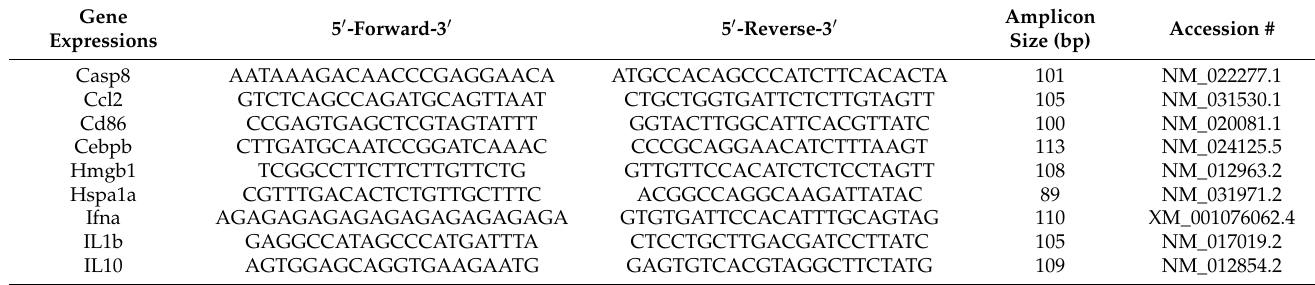
Table 1. Oligonucleotides used for validation of the identified burn-induced TLR gene expressions. Gene